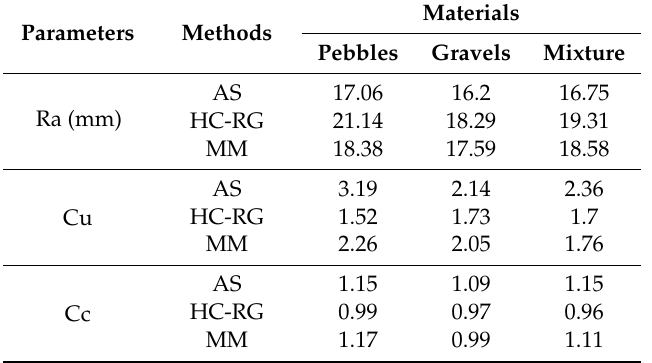
Table 1. Comparison of distribution characteristic parameters among pebbles, gravels, and